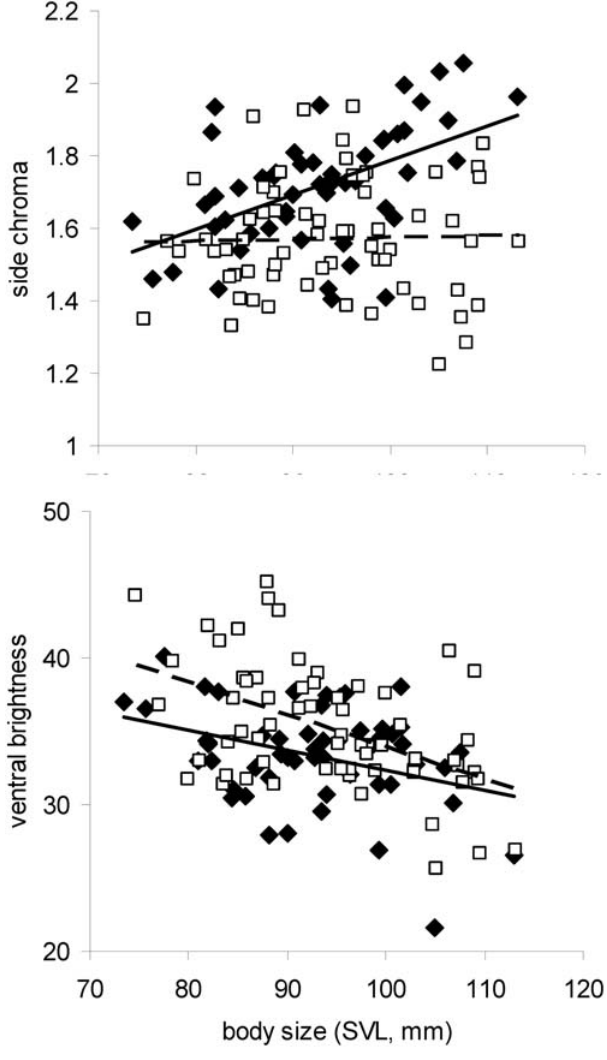
Figure 5. Relationship between body size (SVL) and a) side chroma; b) ventral brightness. Filled diamonds and solid regression line represent the western genetic background while empty squares and dotted regression line represent the eastern background. There is a significant difference between the genetic backgrounds in the slopes in a) and in the intercept in b); see text. Note that there is no overall difference in body size between eastern and western males (F 1 =0.89,